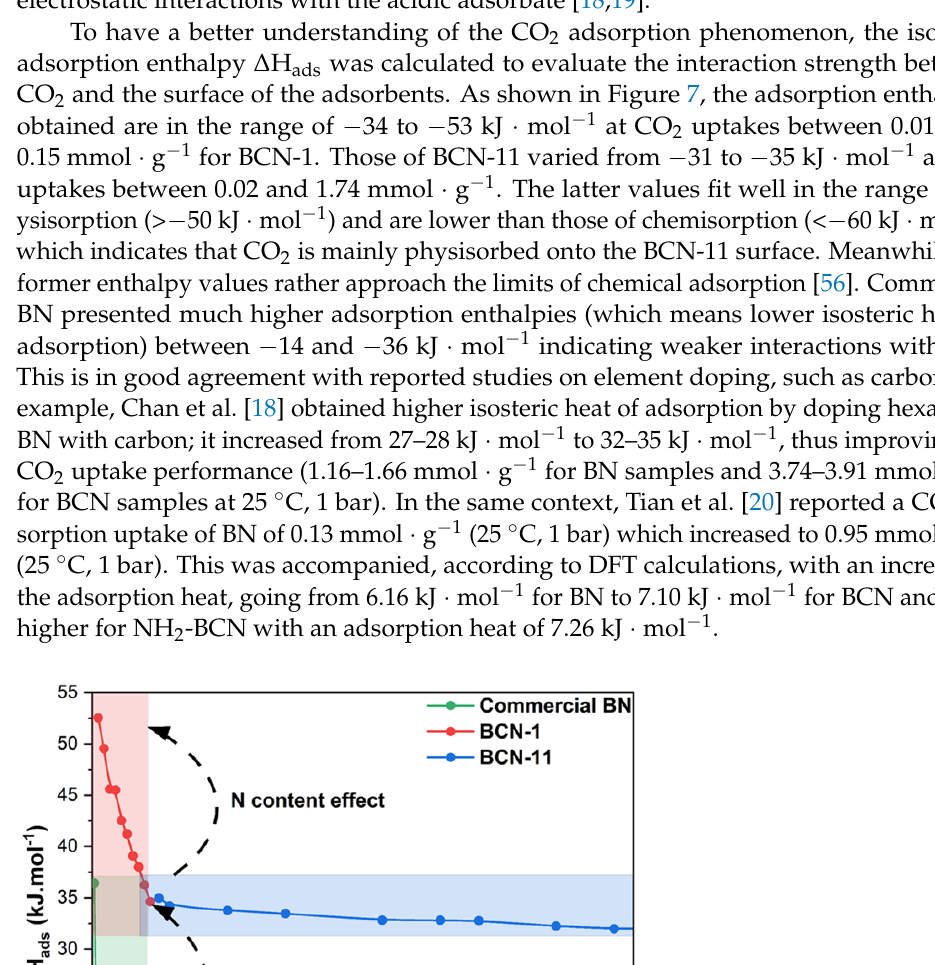
Figure 8. CO 2 recyclability at 25 °C of ( a ) BCN ‐ 1 and ( b ) BCN ‐ 11. In order to capture CO 2 , from either air or flue gas, the selectivity for CO 2 adsorption as opposed to N 2 represents a key factor for these targeted applications. Figure 9 shows the adsorption isotherms of both N 2 and CO 2 at 25 °C. One can see that the amount of CO 2 adsorbed was much higher than that of N 2 in any pressure range. This was further con ‐ firmed by the calculation of the selectivity value based on the IAST method for flue gas composition evaluated to be equal to 26 for BCN ‐ 11. However, since the N 2 adsorption for BCN ‐ 1 at 25 °C is too low, it leads the selectivity equation to diverge to infinity based on Cycle 1